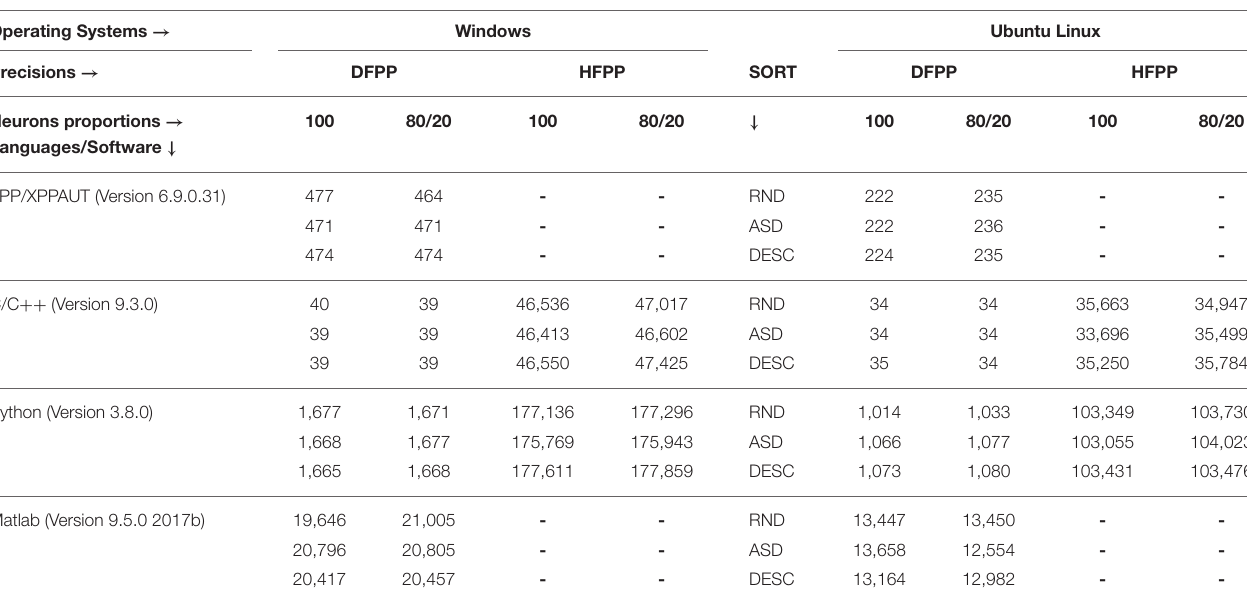
TABLE 5 | Time (in seconds) consumed for each computational